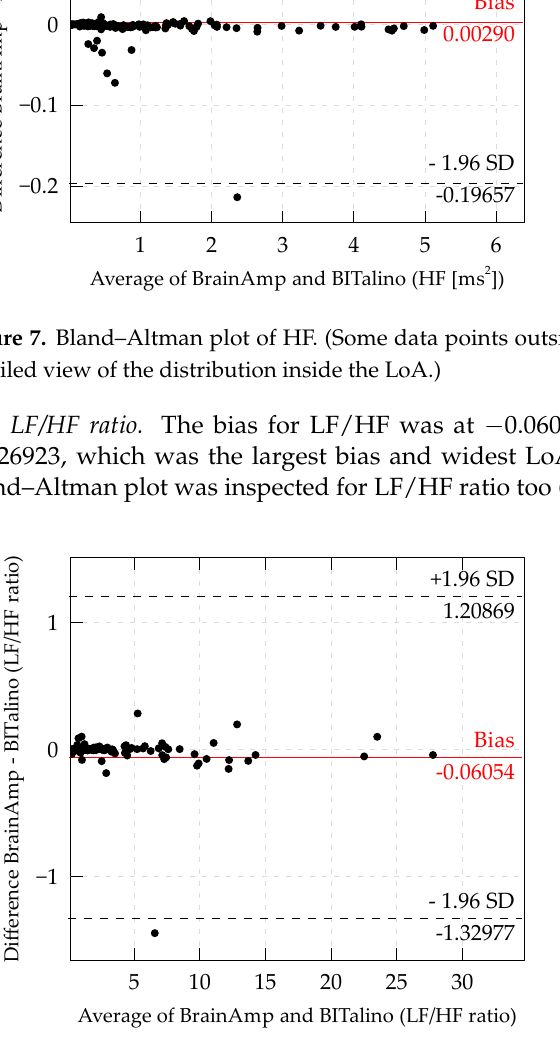
Figure 8. Bland–Altman plot of LF/HF ratio. (Some data points out- side the LoA are cutoff to offer a more detailed view of the distribution inside the